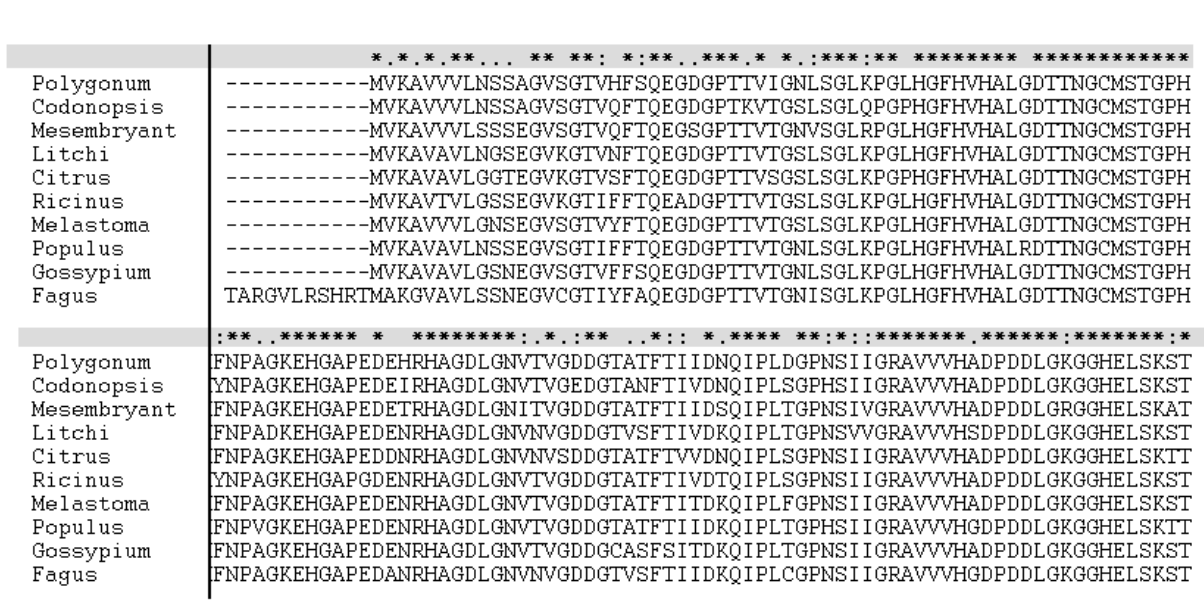
Figure 2. Alignment of the deduced amino acid sequences of PS-CuZnSOD and the known copper-zinc superoxide dismutase from GenBank. Identities compared with those from Melastoma crystallinum ,